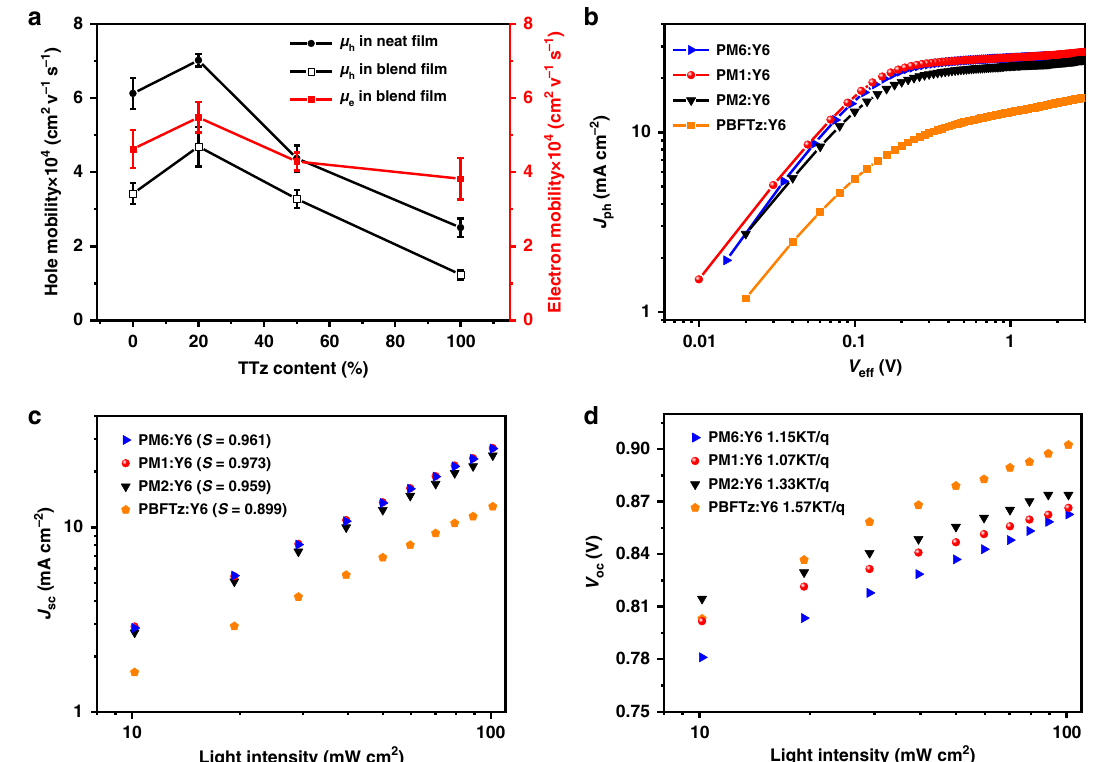
Fig. 4 The electronic characterizations. a Electron and hole mobilities of neat and blend fi lms. b J ph versus V eff curves. c Light intensity dependence of J sc . d Light intensity dependence of V oc